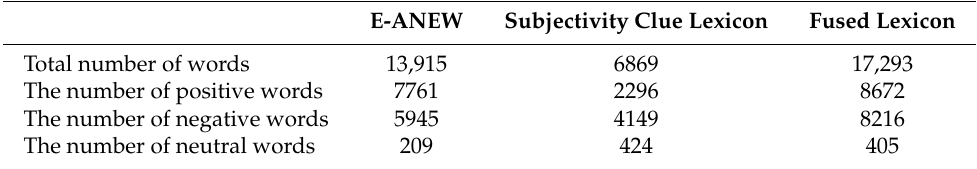
Table 1. The details of the sentiment